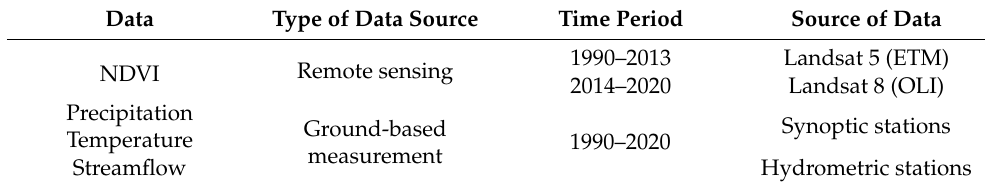
Table 1. The sources of the utilized